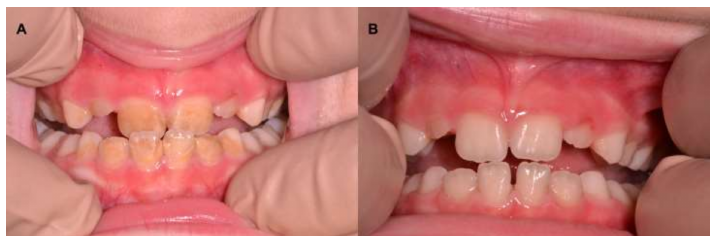
Figure 2. ( A ) Enamel discoloration and presence of calculus stone. ( B ) Picture showing intraoral view of patient shown in Figure 2A after removal of the discoloration and calculus stone in a few sessions of scaling and